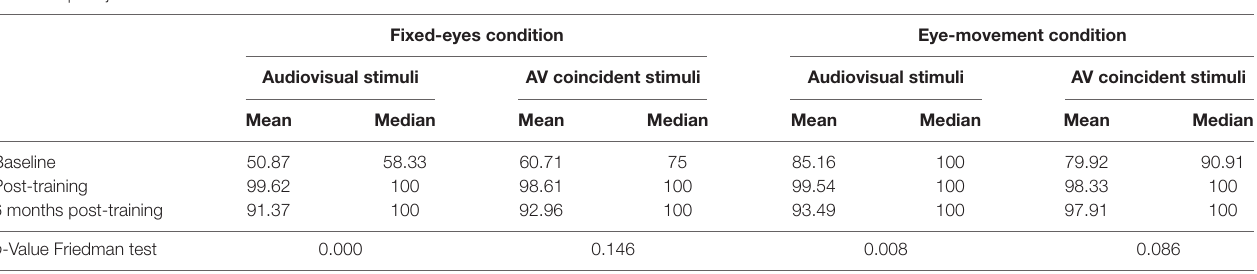
Mean and median percentages of visual detections (hemianopic hemifield) in the different evaluations and p-value of the Friedman Tests.